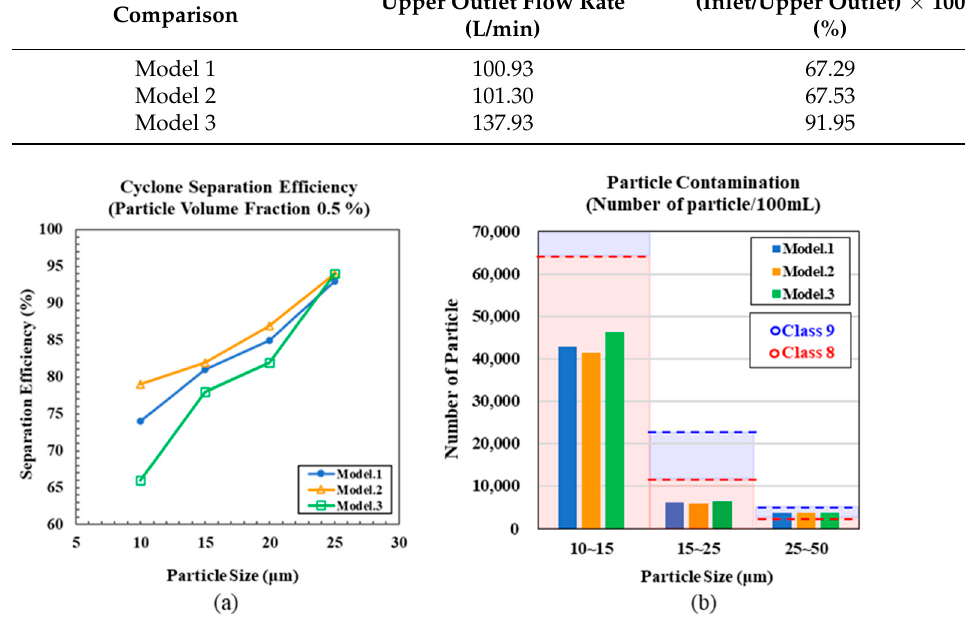
Table 5. Comparison of upper outlet flow rate for cyclone models 1, 2, and 3.